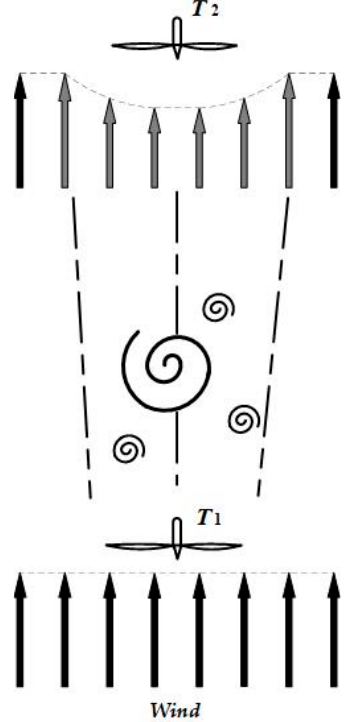
Figure 2. Schematic diagram of wake-deficit